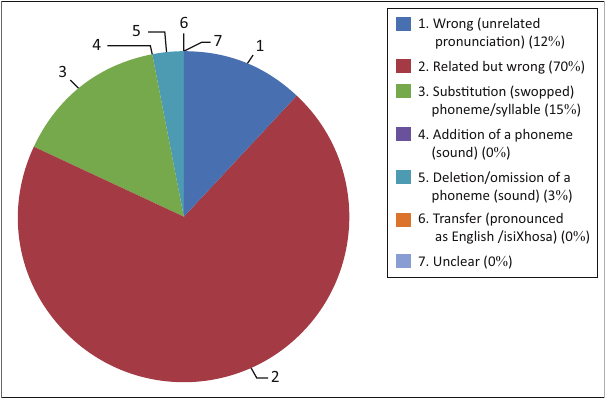
FIGURE 8: School E isiXhosa pseudo-word reading ( n = 40). Mostly lexical